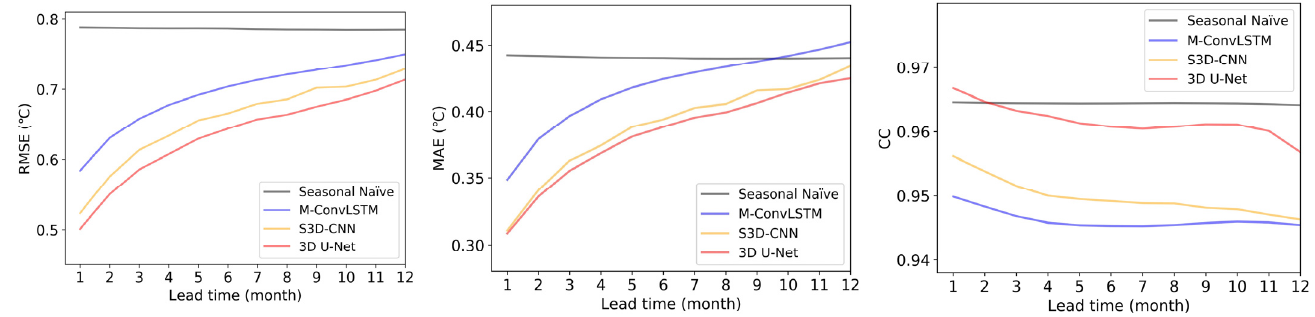
Figure 7. Evaluation of the overall prediction performance of different models.